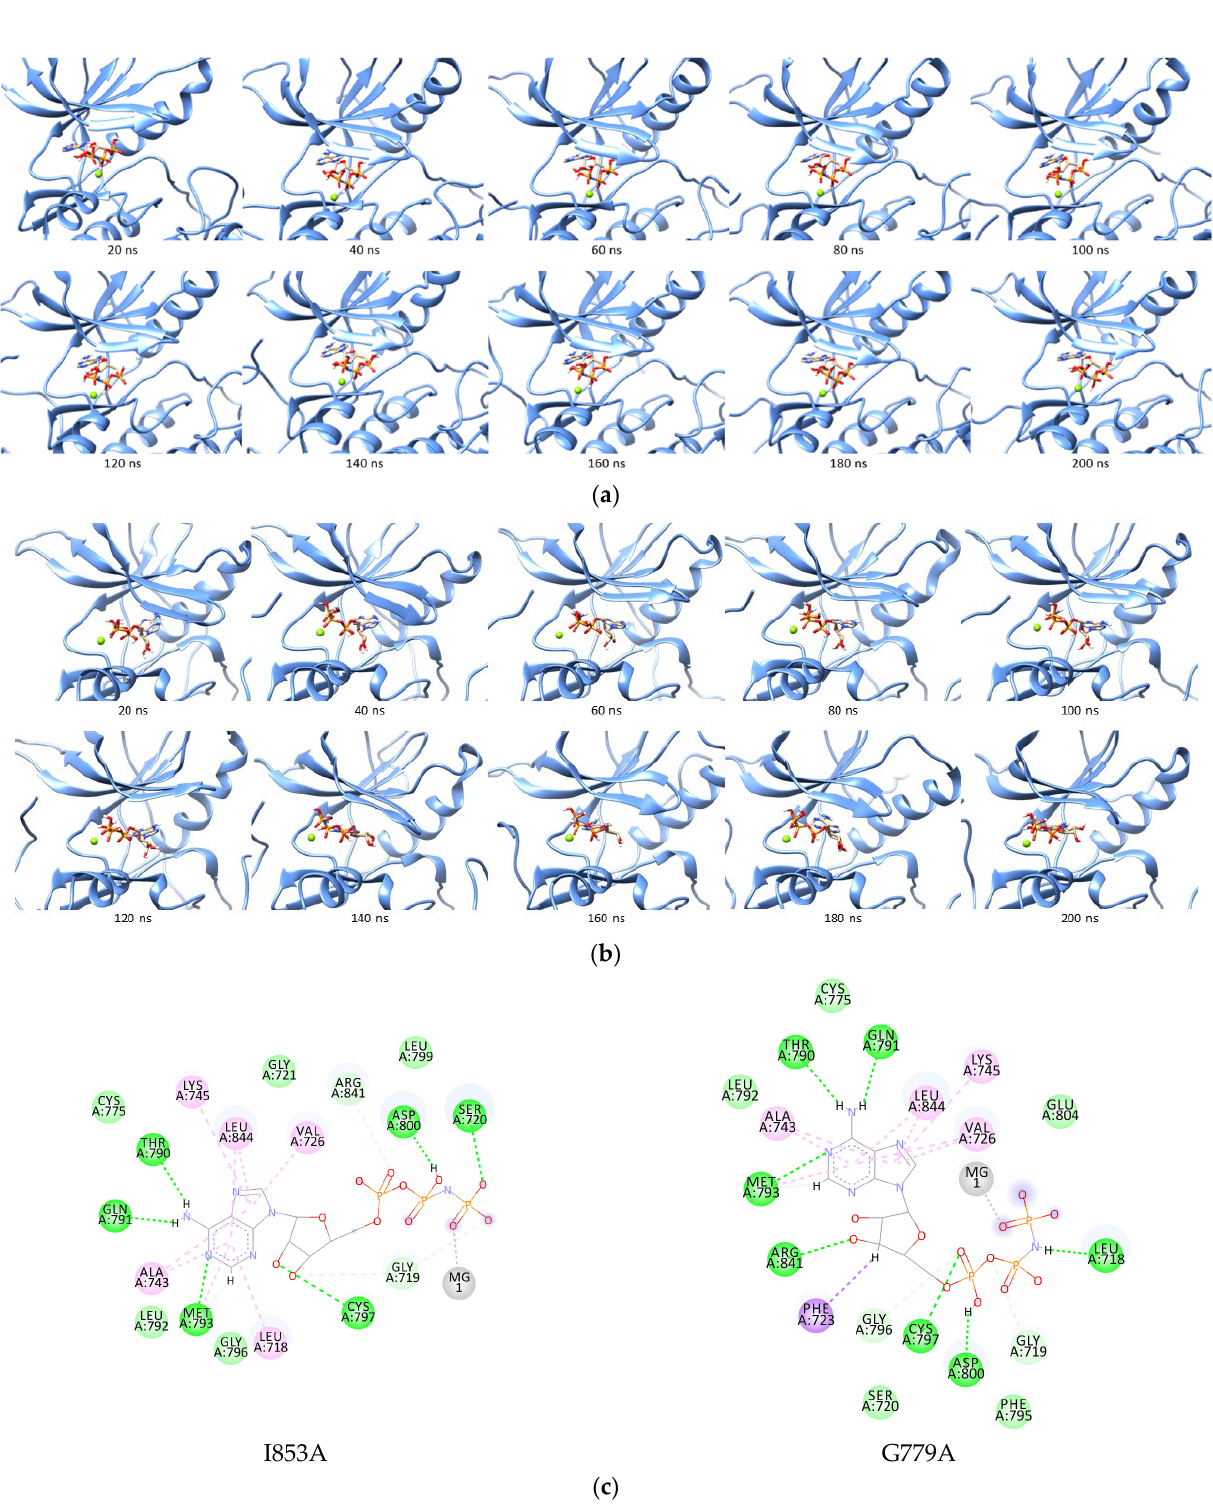
Figure 6. Trajectories of ANP in the I853A ( a ) and G779A ( b ) binding site during simulation, and ( c ) 2D interaction of ANP to the I853A and G779A receptor: , hydrogen bond; , van der Waals; metal acceptor; , pi-sigma; , pi-alkyl. Negative ΔΔ G was predicted to cause an increase in ATP affinity, decreasing the in- hibitor due to the binding competition or resistance. This result has to be further confirmed by the in vitro assay and may become a concern to developing TKIs.